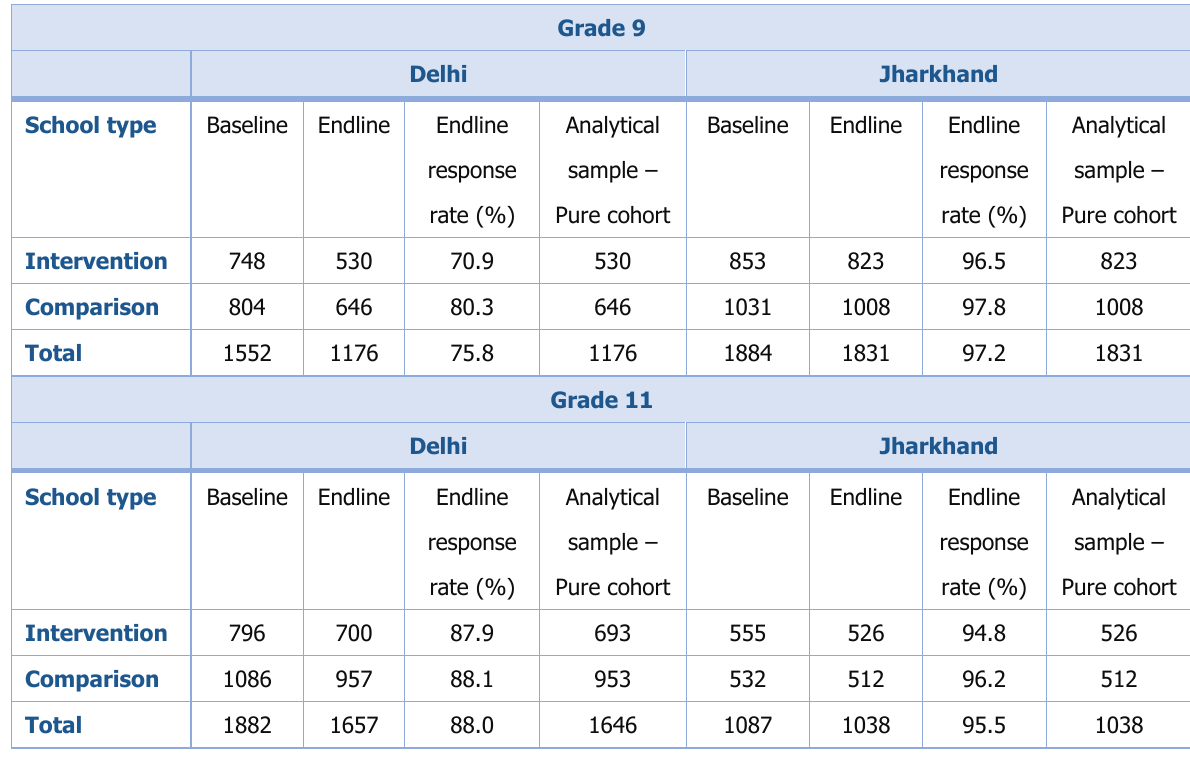
Table 1. Analytical Sample: Girls Who Were Interviewed at Both Baseline and